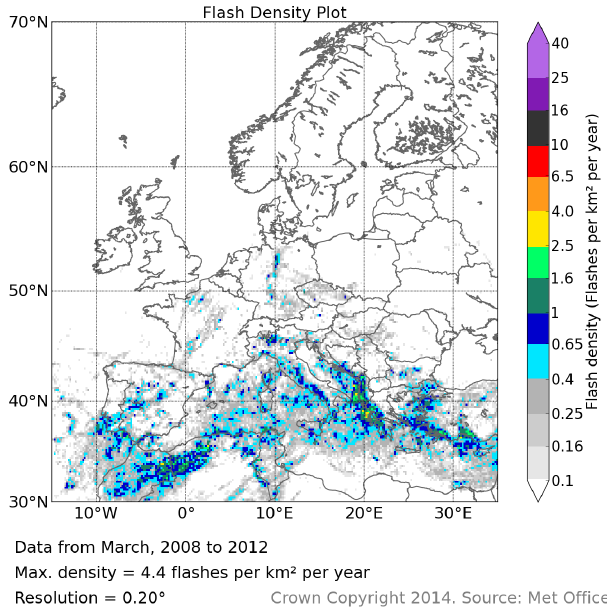
Fig. 5. Detected lightning flash density for January.